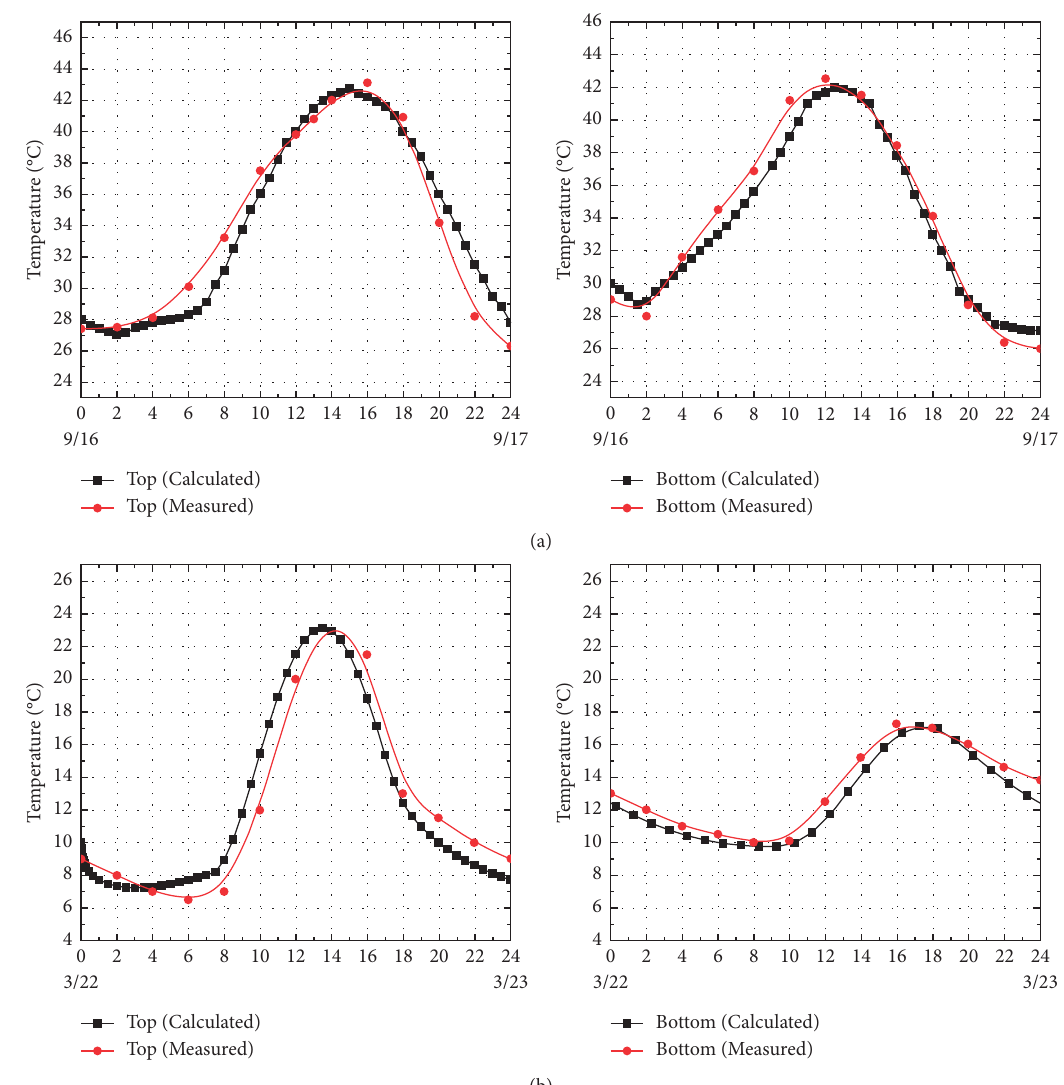
Figure 4: Comparison of measured and calculated temperatures for a 26cm thick slab: (a) summer and (b) winter.